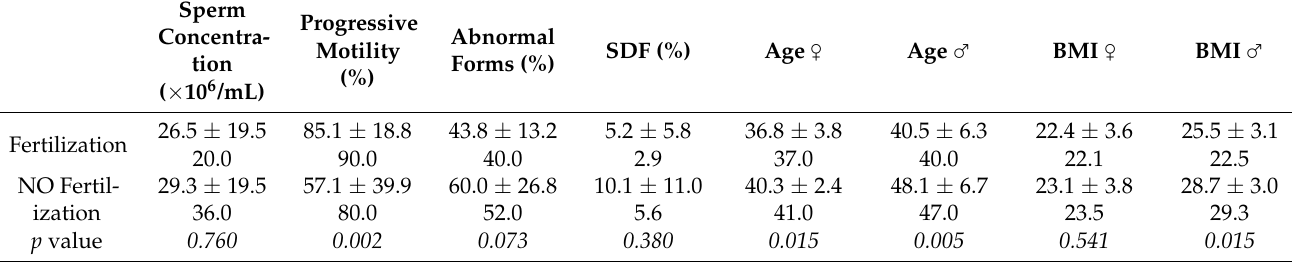
Table 4. The seminal characteristics post sperm selection procedures and demographic characteristics are presented as mean ± SD and median (in italics), according to oocyte fertilization success (Mann Whitney